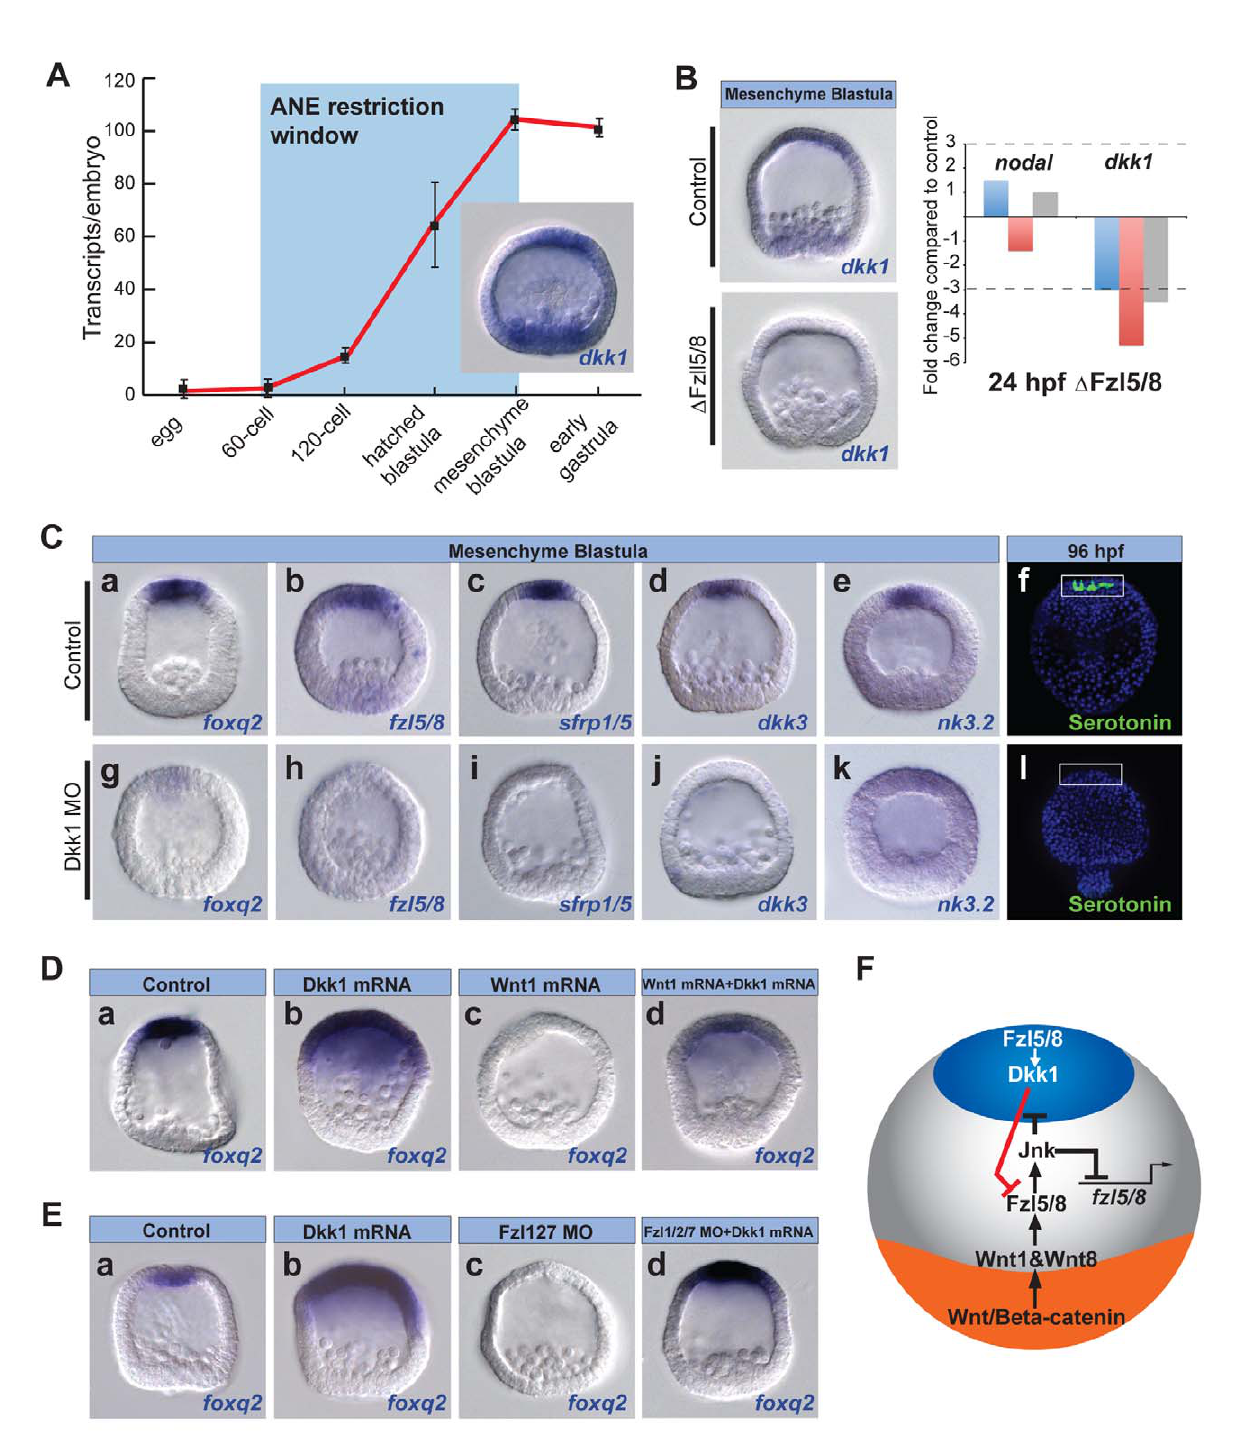
Figure 6. Dkk1 activity defines the ANE territory by antagonizing Wnt signaling. (A) qPCR measurements from three different batches of embryos showing the number of Dkk1 transcripts/embryo at the indicated stages during early development. Values were normalized to z12 transcripts (see Materials and Methods). (B) In situ hybridization (left) and qPCR (right) show that dkk1 expression requires Fzl5/8 signaling ( D Fzl5/8 mRNA). (C) Six ANE markers show that ANE specification requires Dkk1. (D, E) Injected molecules are indicated at the top of panels. (D) Overexpression of Dkk1 prevents foxq2 restriction to the anterior pole and suppression of foxq2 expression by ectopic Wnt1. (E) Overexpression of Dkk1 rescues foxq2 expression in embryos co-injected with Fzl1/2/7 morpholino. (F) Diagram showing a model for ANE restriction based on the data presented in this and previous figures. MO, morpholino.